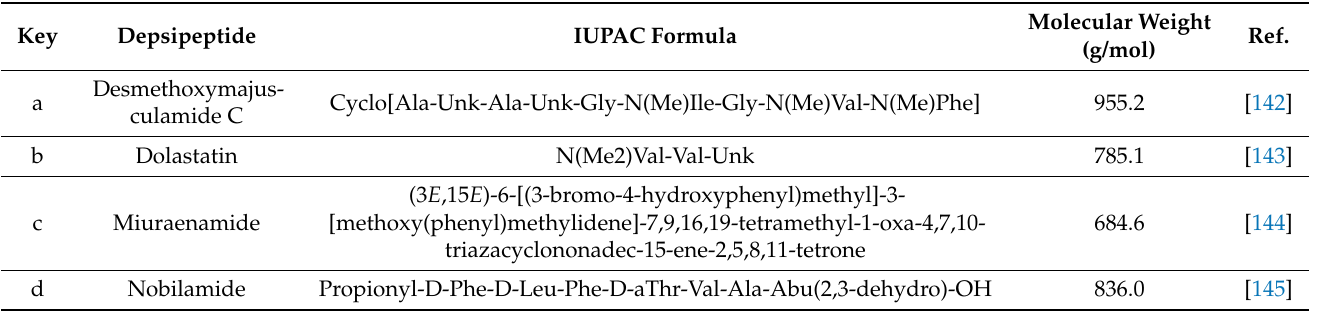
Table 5. Formula and molecular weight of depsipeptides inducing microfilament disruption in tumor